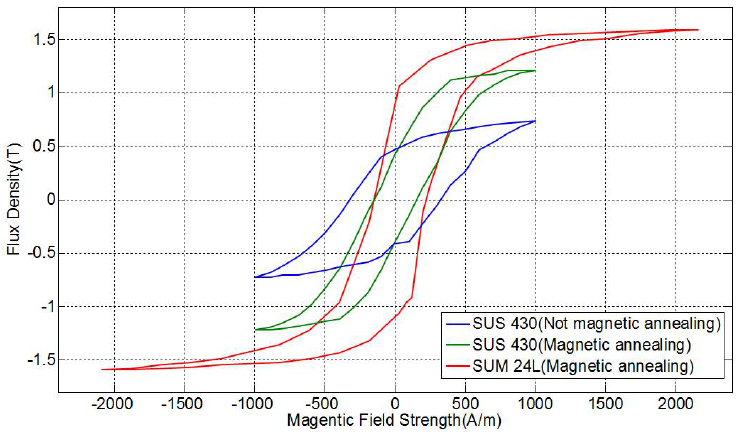
Figure 15. B-H curves of material.